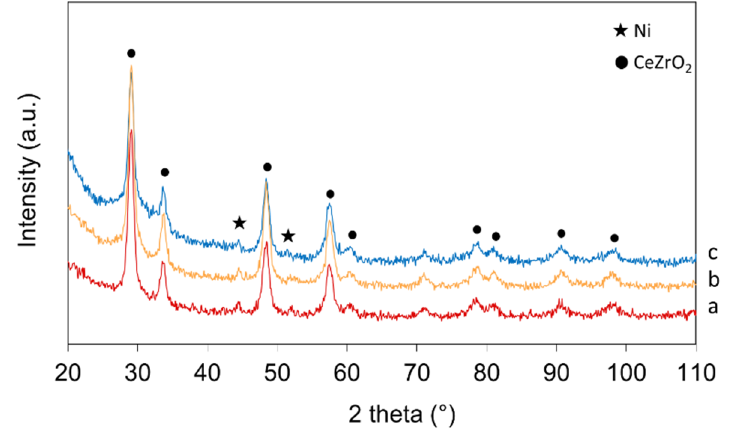
Figure 2. The XRD patterns of the Ni/CeZrO 2 catalyst: fresh ( a ) and spent in SRT at S/C = 1 ( b ) and S/C = 4 ( c ). Table 3. The textural properties of Ni/CeZrO 2 before and after catalytic runs of SRT. Ni/CeZrO 2